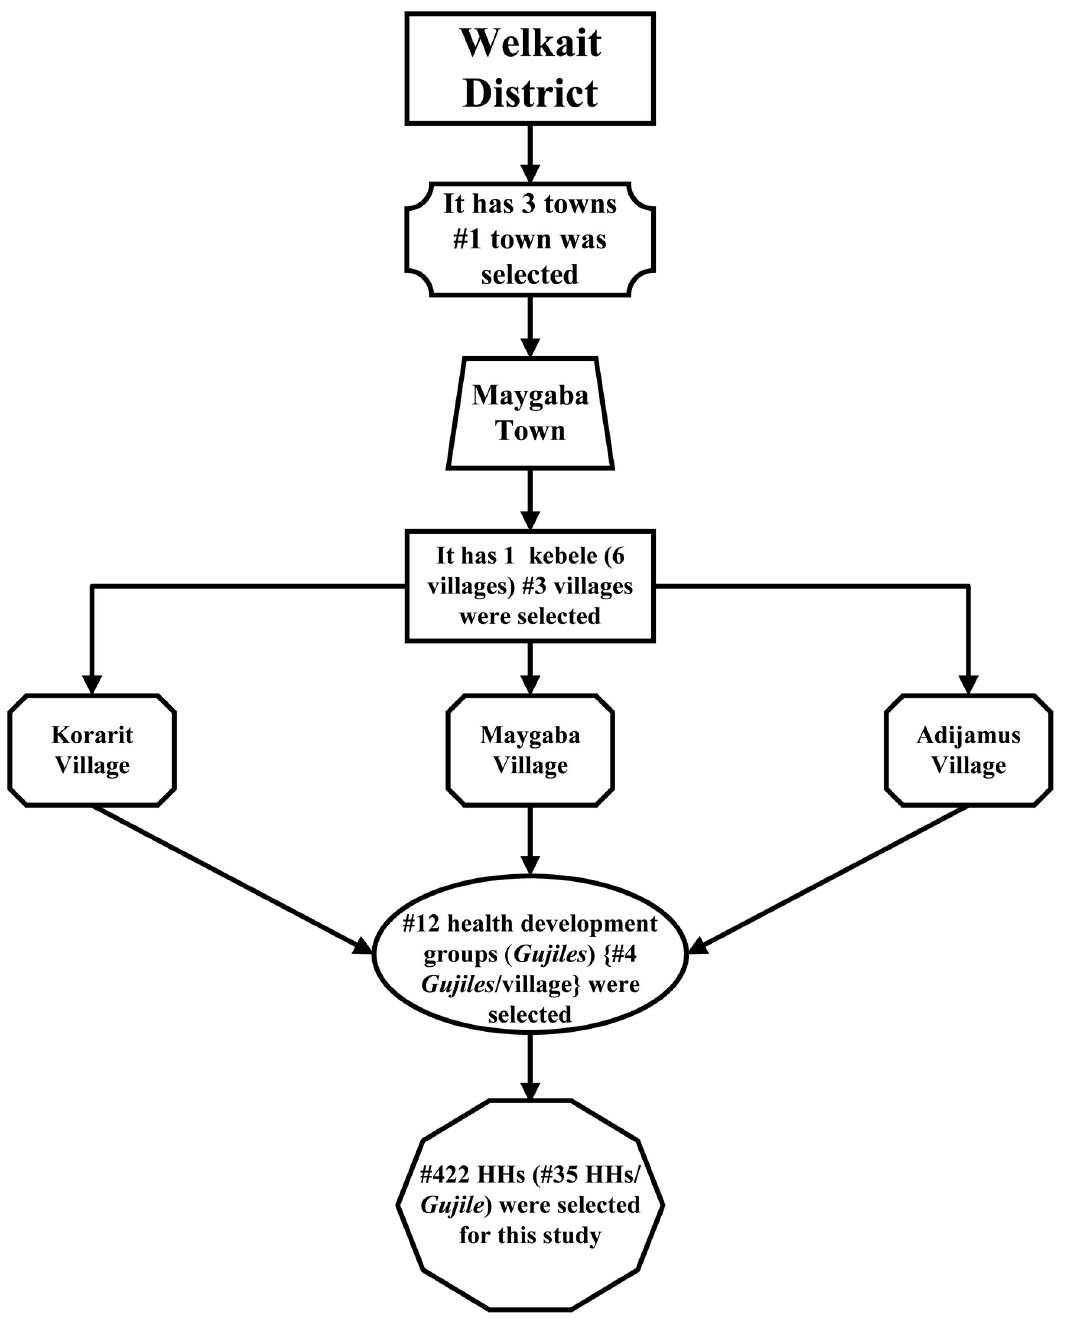
Fig 1. Flow chart indicating the multi-stage cluster random sampling